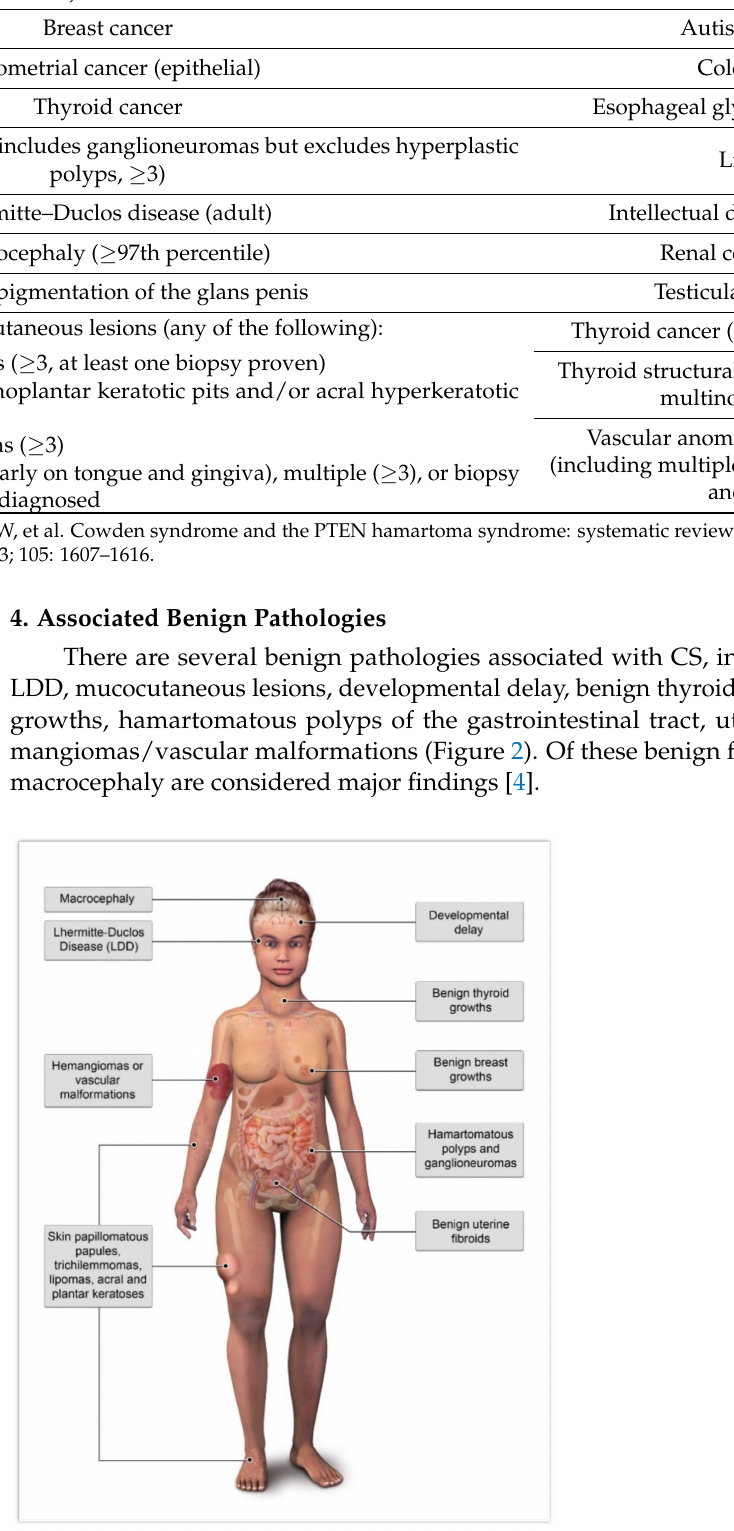
Figure 2. Illustration of common benign pathologies associated with Cowden